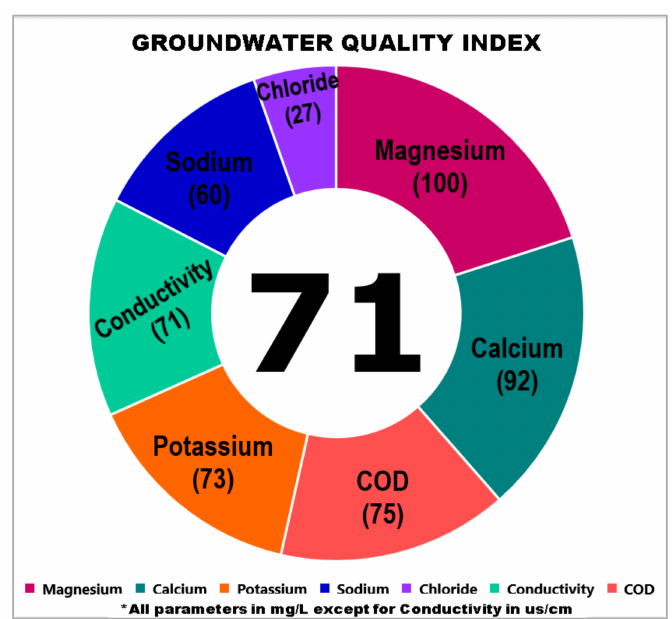
Figure 7. Change in the index value as Mg concentration